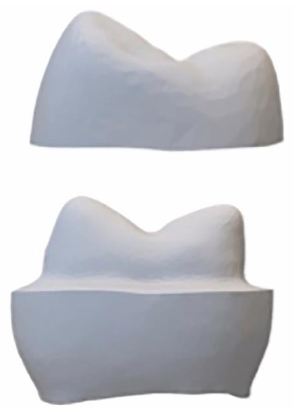
Figure 3. STL 2 file split in top and bottom layers. Table 1. Physical and mechanical properties of additive manufactured zirconia and alumina tough- ened zirconia material. Information provided by the manufacturer. Physical/Mechanical Properties